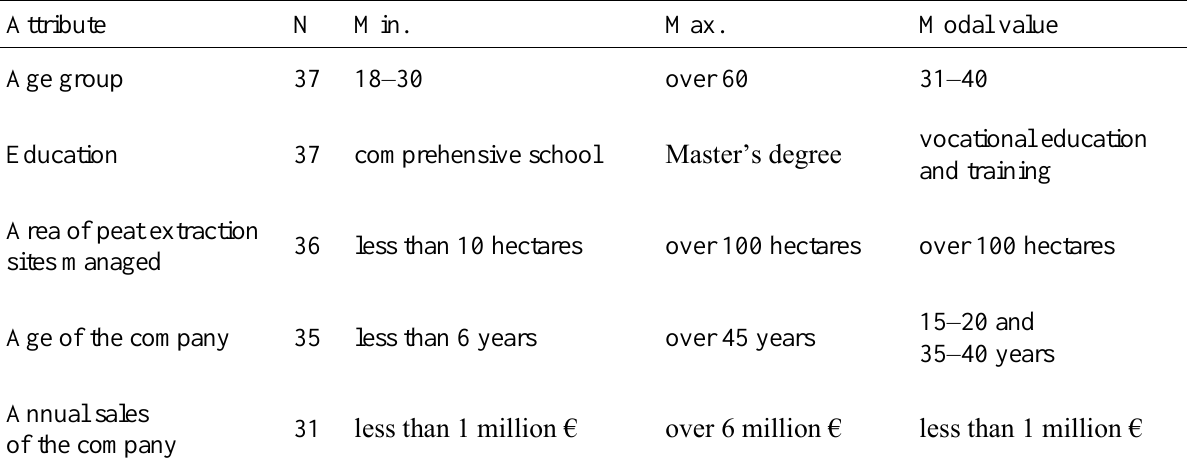
Table 2. Descriptive statistics for the backgrounds of respondents.